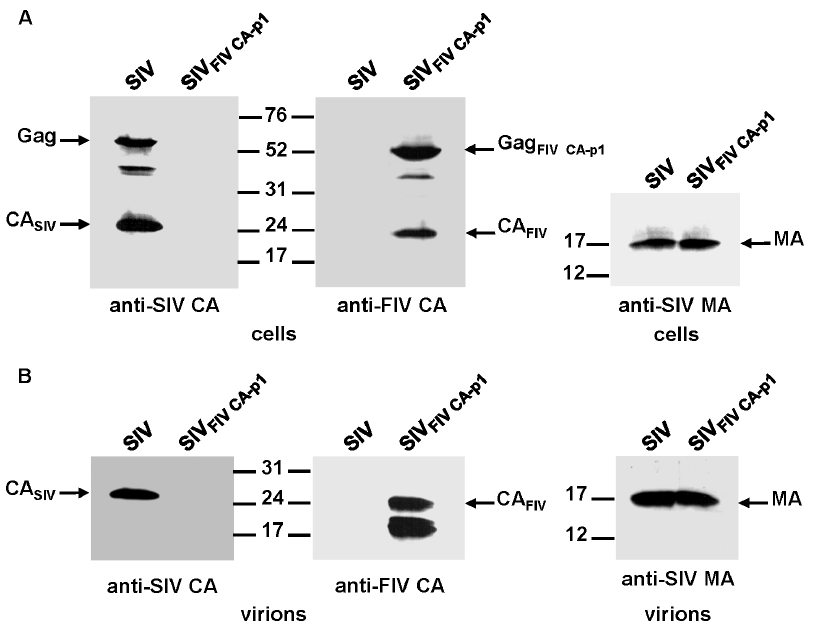
Figure 3. Assembly phenotype of the SIV FIV CA-p1 chimera. 293T cells were transfected in parallel with wild-type SIV SMM-PBj and SIV FIV CA-p1 proviral DNAs. Protein blots of cell (A) and virion (B) lysates were probed with antibodies specific for the SIV MA, SIV CA, and FIV CA proteins. The positions of the wild-type and chimeric Gag precursors, as well as those of the mature SIV MA, SIV CA, and FIV CA proteins are shown. Numbers indicate the positions of the molecular weight standards (in kDa).